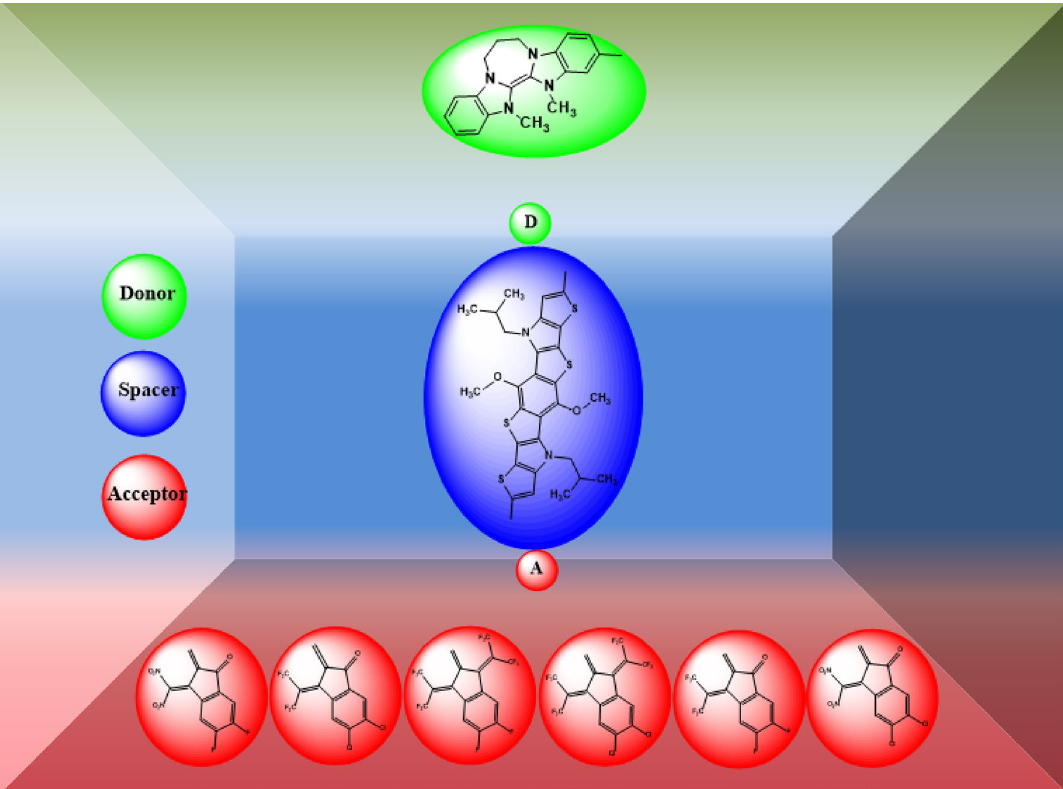
Figure 2. A structural map is consisting of acceptor (red color), spacer (blue color) and donor (green color) of the entitled compounds. These structures are drawn with the help of ChemDraw software (https:// chemi stryd ocs. com/ chemd raw- pro-8- 0/).